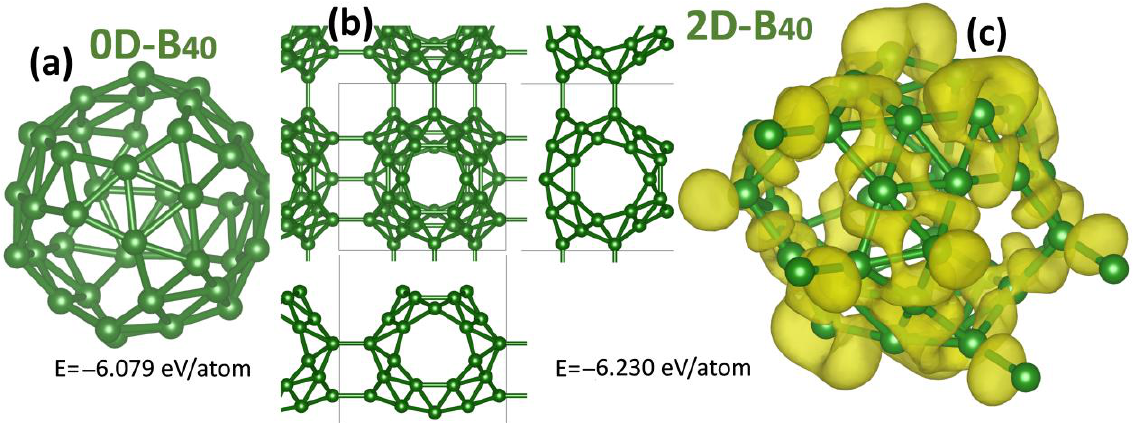
Figure 1. ( a ) 3D view of the B 40 cage. ( b ) Top and side views for the 2D boron fullerene network. ( c ) 3D view for the electronic localization function (with yellow color) of the 2D boron fullerene network with an isosurface value of 0.75, illustrated using the VESTA package [31]. Find the energy minimized structures in the Supporting Information document.